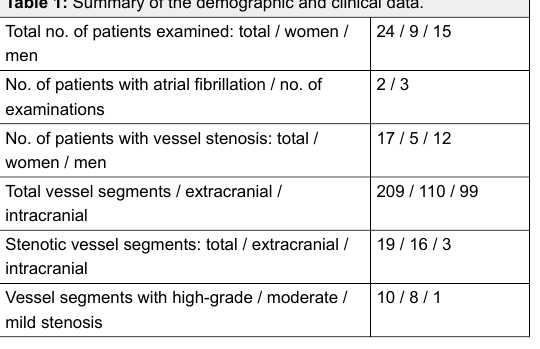
Table 1: Summary of the demographic and clinical data.